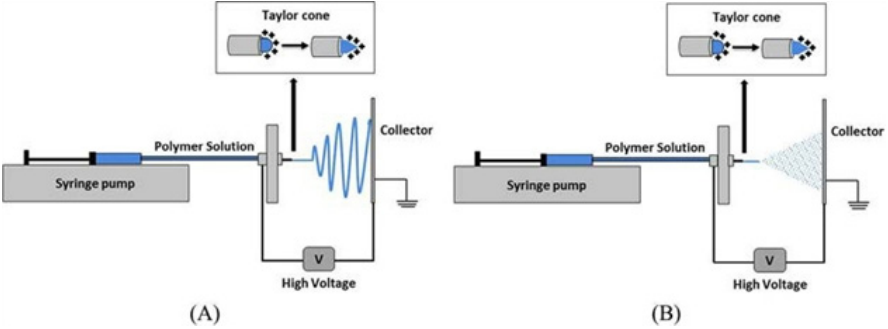
Figure 7. ( A ) Electrospinning and ( B ) electrospraying (reproduced with permission) [185]. The droplets or fibers produced are solidified as the solvent evaporates, thereby forming the products between the nano ‐ and micro ‐ scale. Some of the processing parameters affecting particle/fiber morphology include solution properties (e.g., viscosity, polymer concentration, surface tension, electrical conductivity), operational conditions (e.g., applied voltage, flow rate, tip ‐ to ‐ collector distance), and ambient conditions (e.g., temperature, humidity).